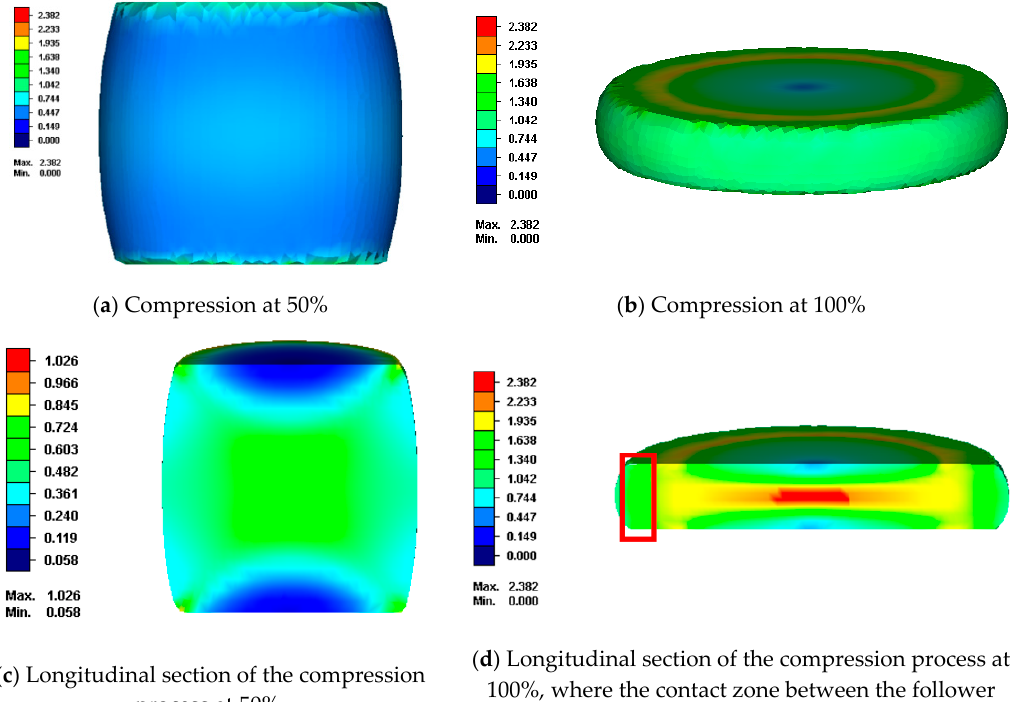
Figure 7. Plastic strain distribution during the manufacturing process of disks for AA ‐ 5083.